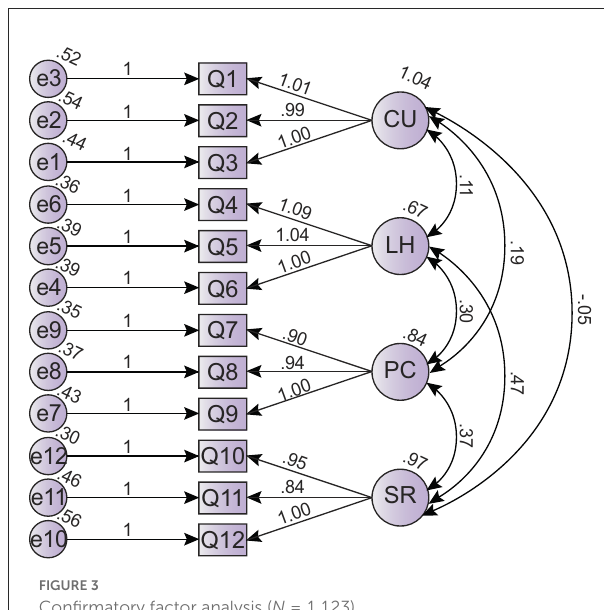
FIGURE3 Confirmatory factor analysis ( N =